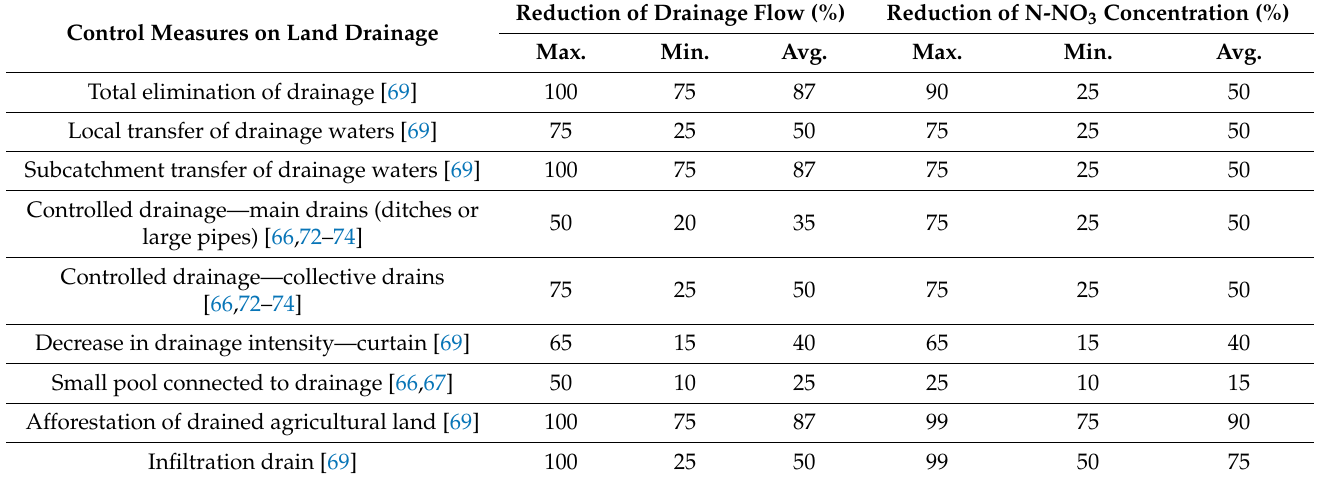
Figure 3. Erosion phosphorus input into fourth-order catchments for the entire Vltava watershed area. 3.2. Drainage Pollution Sources—Critical Points and Their Categorization For all hydrological units with critical points, the CAMNI values were determined and then converted into risk levels within the entire Vltava River watershed area. From a total 138 assessed water bodies, according to CAMNI, 19 were classified as risk level 5 (extremely high need of control measures), while 25 were categorized as risk level 4 (high need of control measures). On the other hand, for 26 water bodies, the need for control measures was assessed as being either very low or low. Concerning the fourth-order